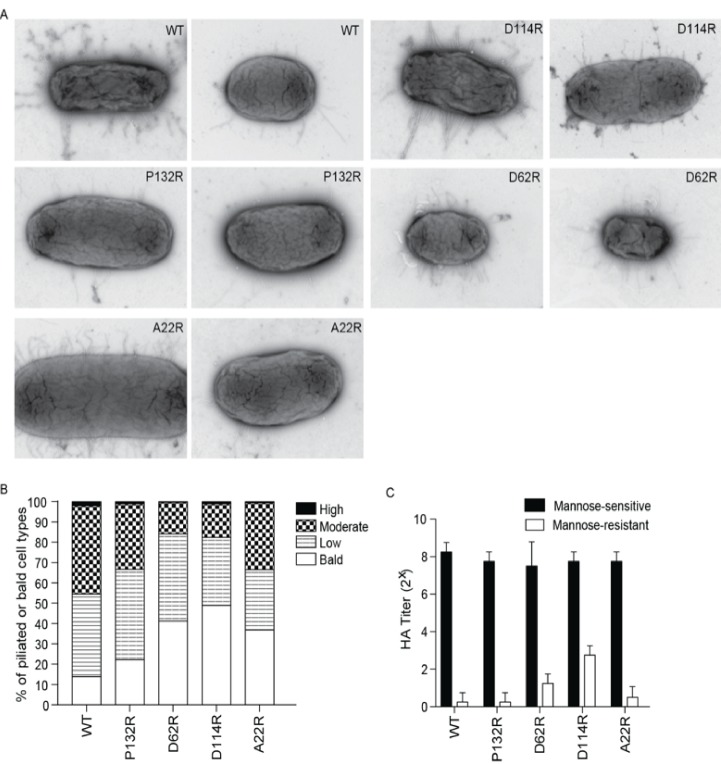
Chromosomally integrated point mutations in fimA gene do not prevent the expression or function of type 1 pili in vitro.(A) Representative negative stain EM images of UTI89 strains producing WT FimA or one of the indicated mutant variants. (B) Percentage of bald, lowly-, moderately-, and highly-piliated cells in the different UTI89 populations. (C) The relative ability of the WT strain and each mutant to bind and agglutinate guinea pig red blood cells as assessed by hemagglutination titer analysis. Abbreviations: HA = hemagglutination assay. Bars represent mean ±SD (C). N = 600 cell counted per mutant, two biological replicates (B); N = 4 biological replicates with two technical replicates each (C).